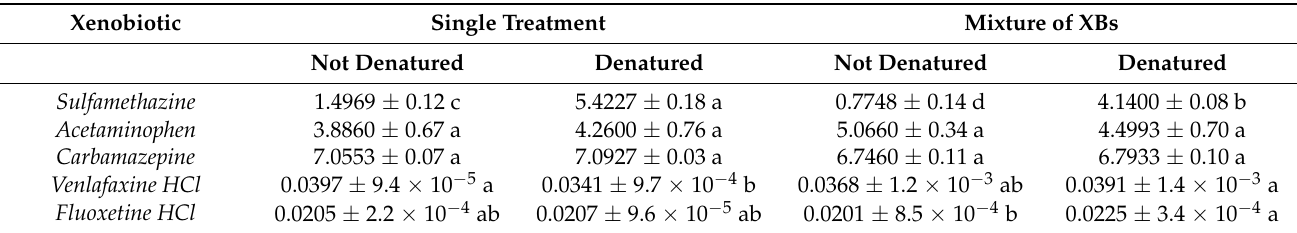
Table 5. Xenobiotic degradation (mg L − 1 ) by crude plant extract. Initial concentration of 5 mg L − 1 . Values show the mean (in mg L − 1 ) ± standard error of three replicates per